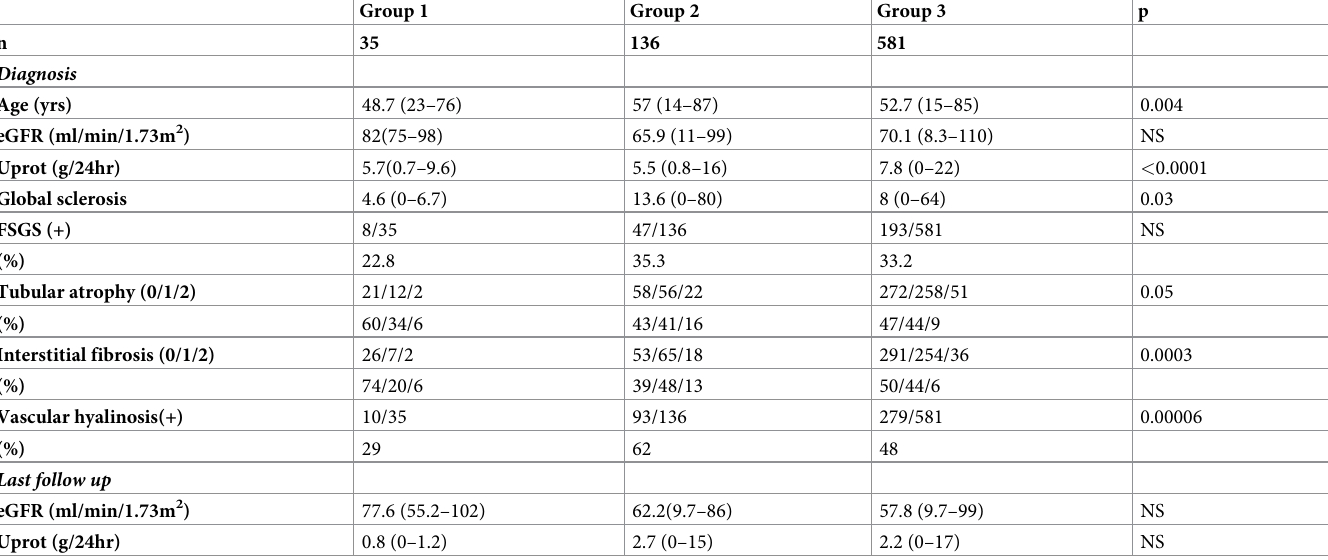
Table 2. Clinical characteristics and histology in patients treated with different therapeutic